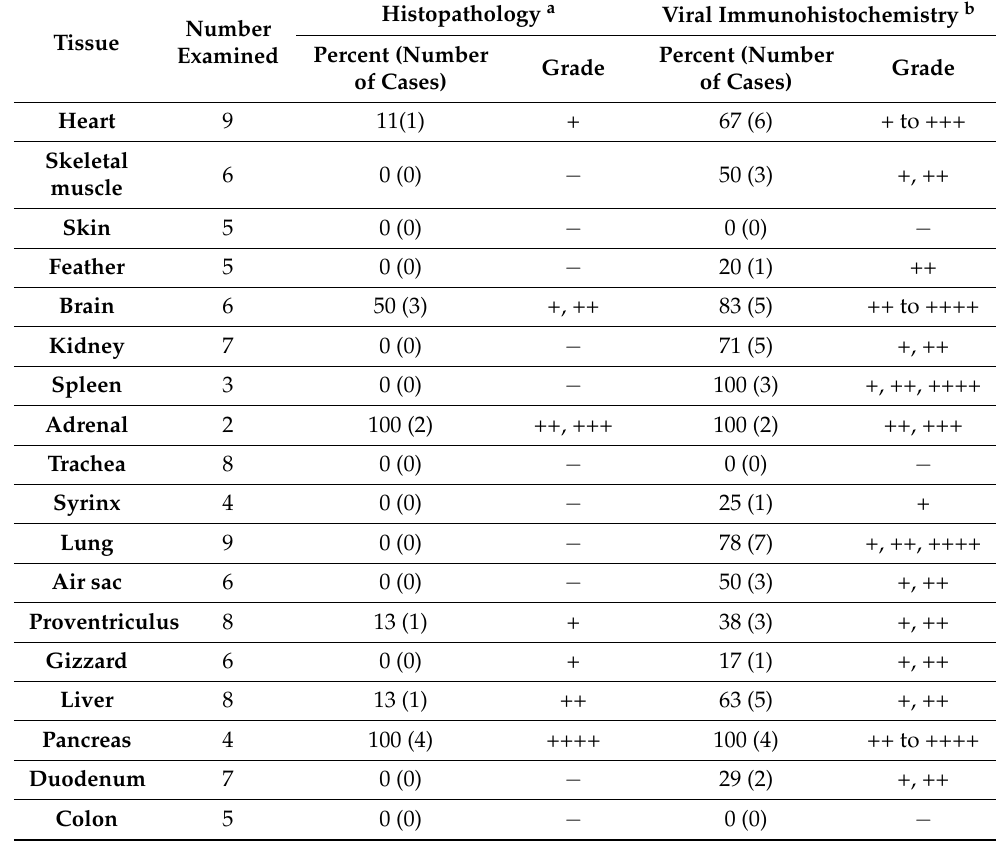
Table 2. Summary of histopathology and viral immunohistochemistry